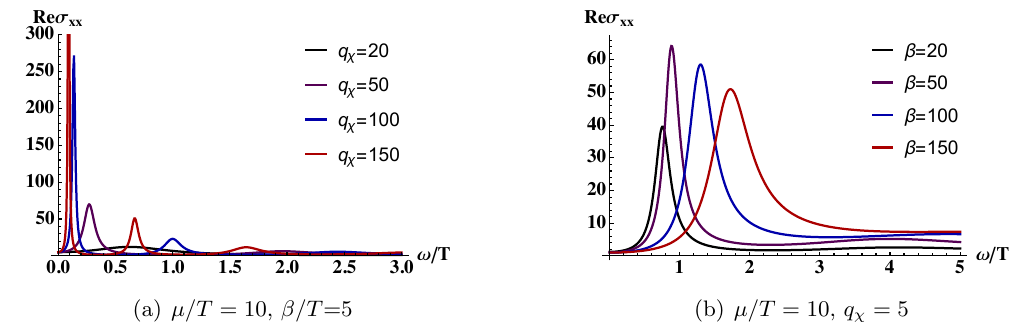
Figure 7 . (a) q (cid:31) evolution of optical conductivity for large q (cid:31) . (cid:22)=T = 10, (cid:12)=T = 5 and H = 0. Notice that number of peaks increases as q (cid:31) increases. (b) (cid:12) evolution of optical conductivity for